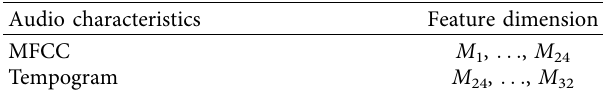
Figure 1: Schematic diagram of the network structure of the dance generative Table 1: Table of music features.